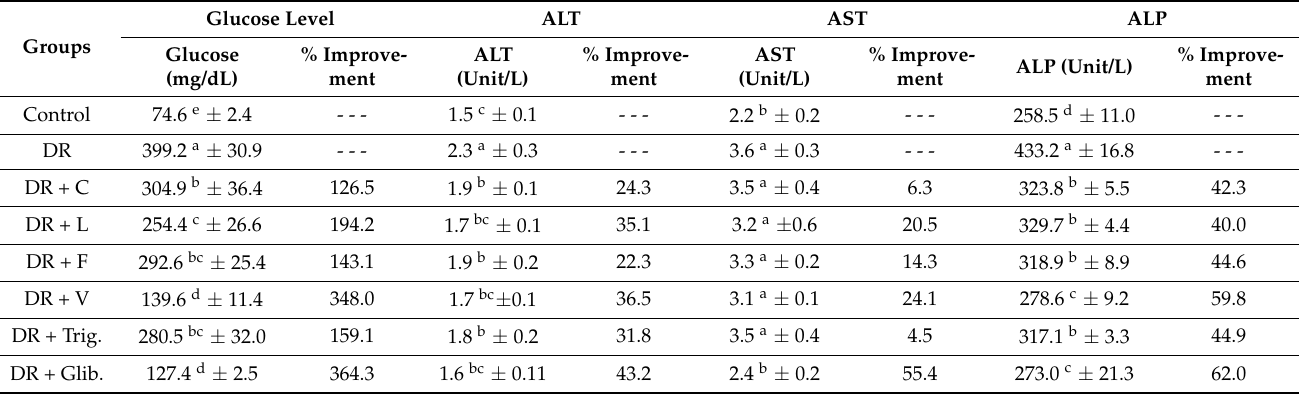
Table 1. Effect of different treatments on serum alanine aminotransferase (ALT), aspartate amino- transferase (AST), and alkaline phosphatase (ALP) of diabetic rats (n =